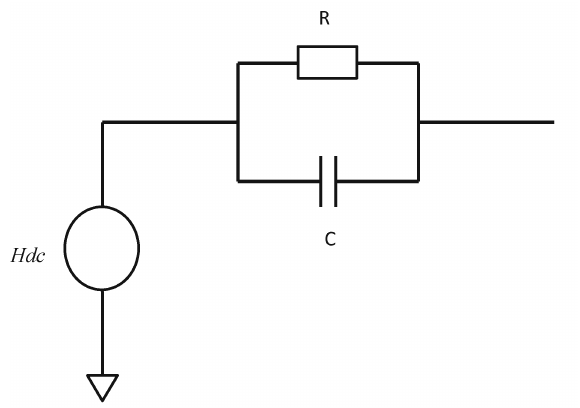
Figure 17: Modified Magnet Model with Frequency Depen- dent Reluctance